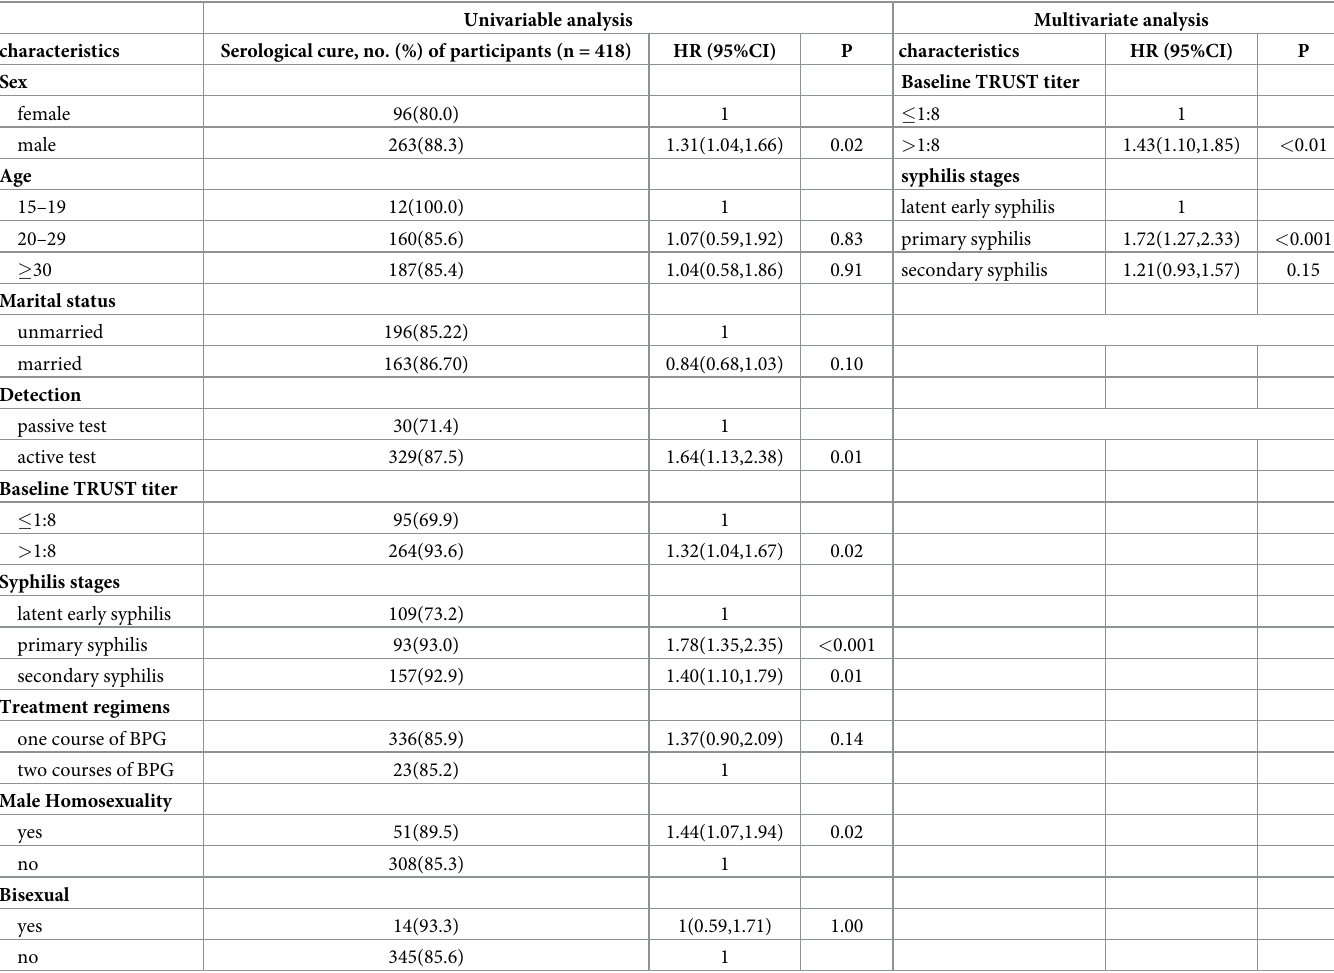
Table 1. Univariable and multivariate Cox proportional hazard analysis of the characteristics of patients who achieved serological cure. Univariable